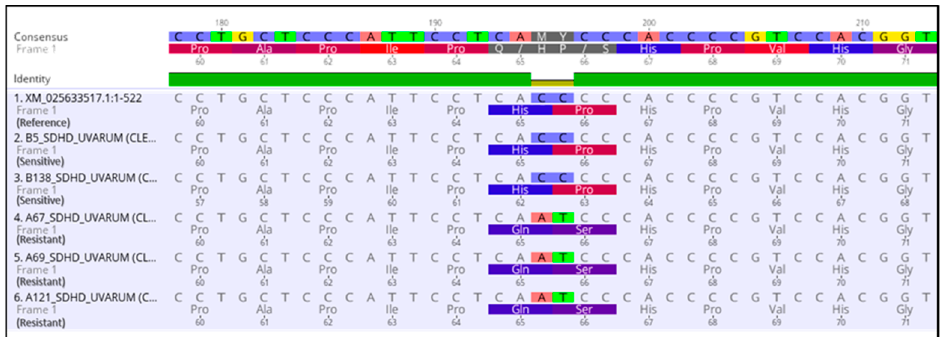
Figure 4. Multiple sequence alignment of nucleotides and amino acids of the sdhD gene in SDHI resistant isolates of Aspergillus uvarum possessing H65Q/P66S mutations.